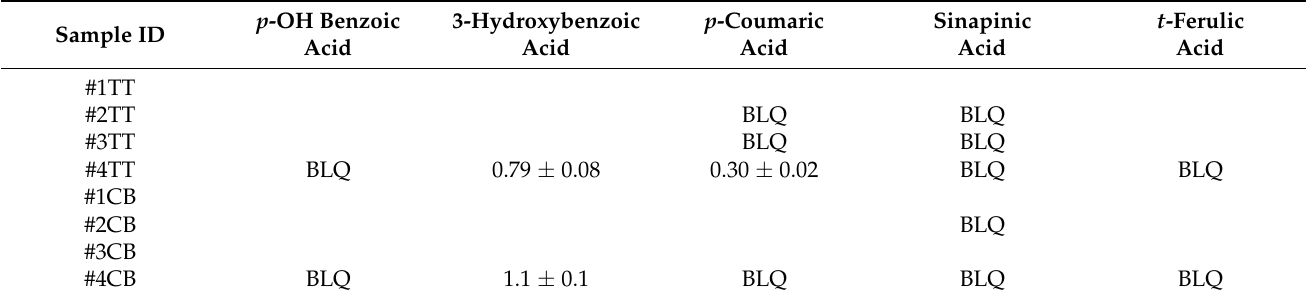
Table 1. Quantitative analysis ( µ g/mg) of the Phaseolus Vulgaris